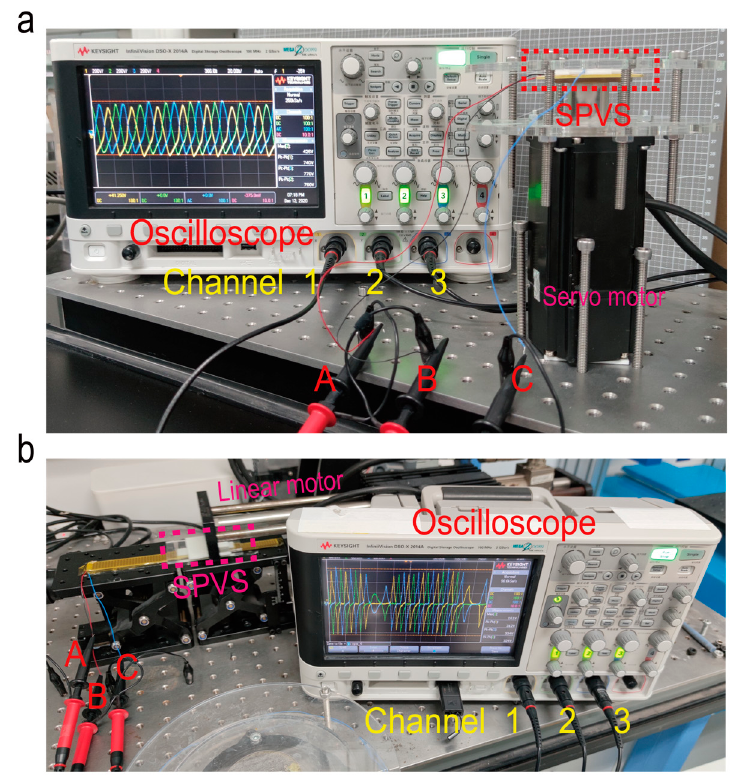
Figure 4. Photograph of the experimental setup for ( a ) disc-shaped SPVS and ( b ) strip-shaped SPVS.